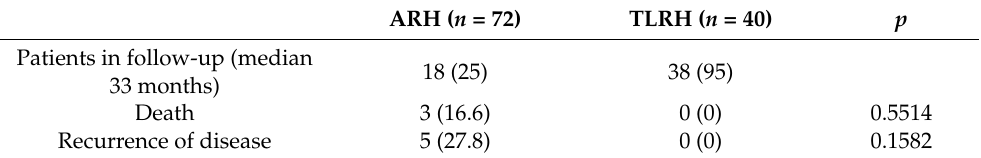
Table 5. Follow-up in women who underwent abdominal radical hysterectomy (ARH) and total laparoscopic radical hysterectomy (TLRH) for cervical